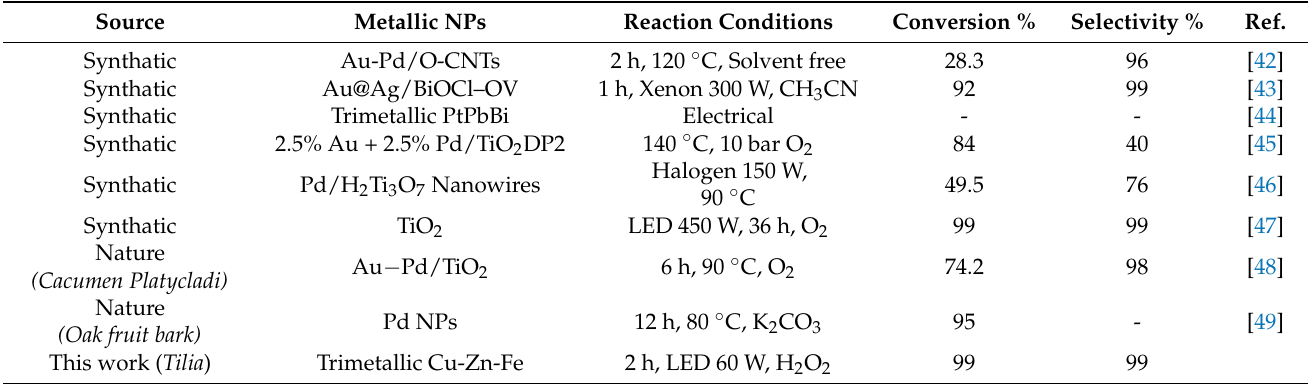
Table 5. A comparison studies using di- and trimetallic NPs as catalyst to oxidize alcohols.